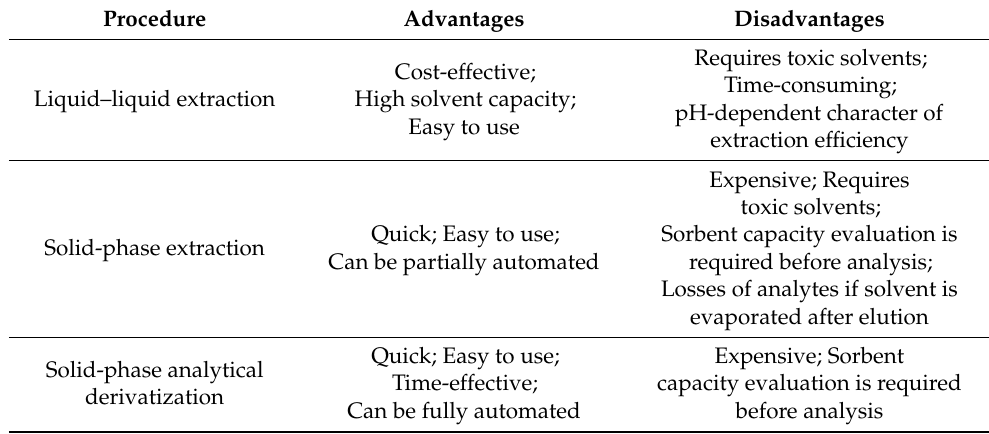
Table 3. Comparison of different methodologies for sample preparation used for steroid determi- nation.